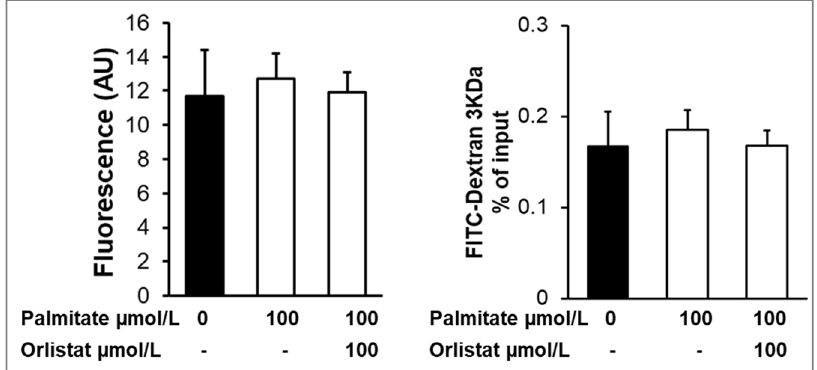
Figure 8. Treatment with FITC and FITC-Dextran. MECs were treated with palmitic acid and orlistat added to the lactation medium in the basolateral chamber for 48 h. FITC or FITC-dex was added to the basolateral chamber, and the cells were incubated for 1 h; the basolateral and apical media were aspirated separately, and fluorescence intensity was measured. Values are AU for FITC and percent of flux into the apical chamber/total FITC (Mean ± SE). Each treatment was performed in quadru- plicate.